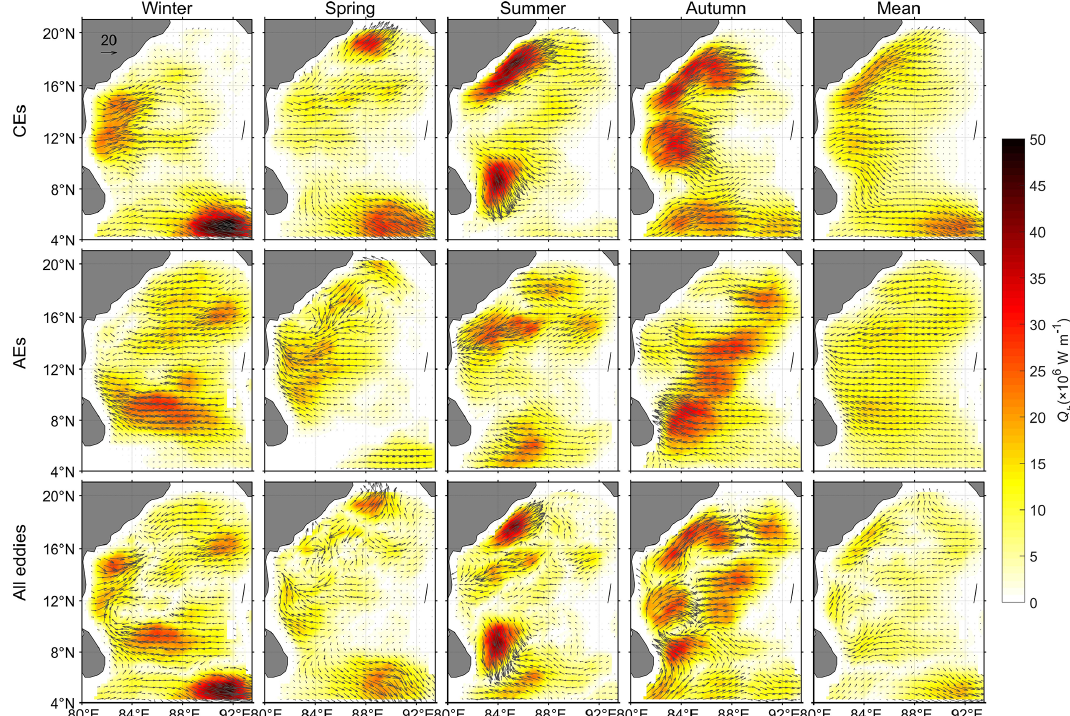
Figure 9. Seasonal eddy-induced heat transport Q h in the Bay of Bengal: results for cyclonic eddies (CEs) (top row), results for anticyclonic eddies (AEs) (middle role), and results for all eddies (bottom row). Here, Q h = (Q hm ,Q hz ) is a vector whose components are the meridional and zonal heat transports, the arrows indicate the transport direction, and the color indicates the transport